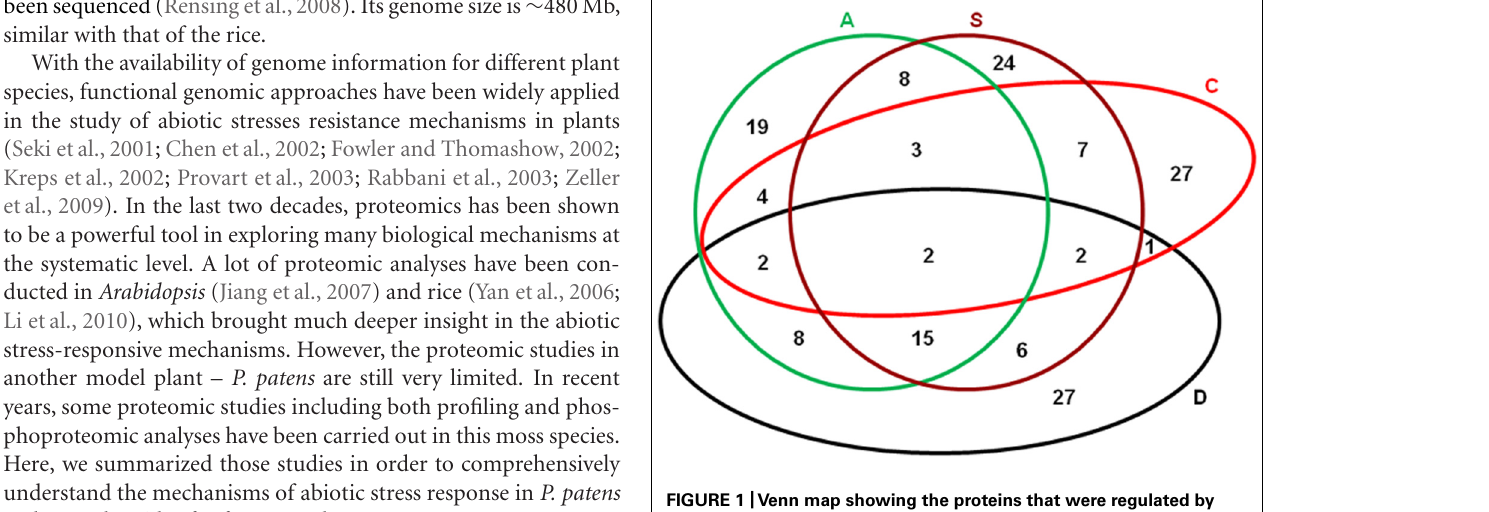
repressed by the abiotic stresses, although most of the treatments (not including dehydration) did not result in the inhibition of